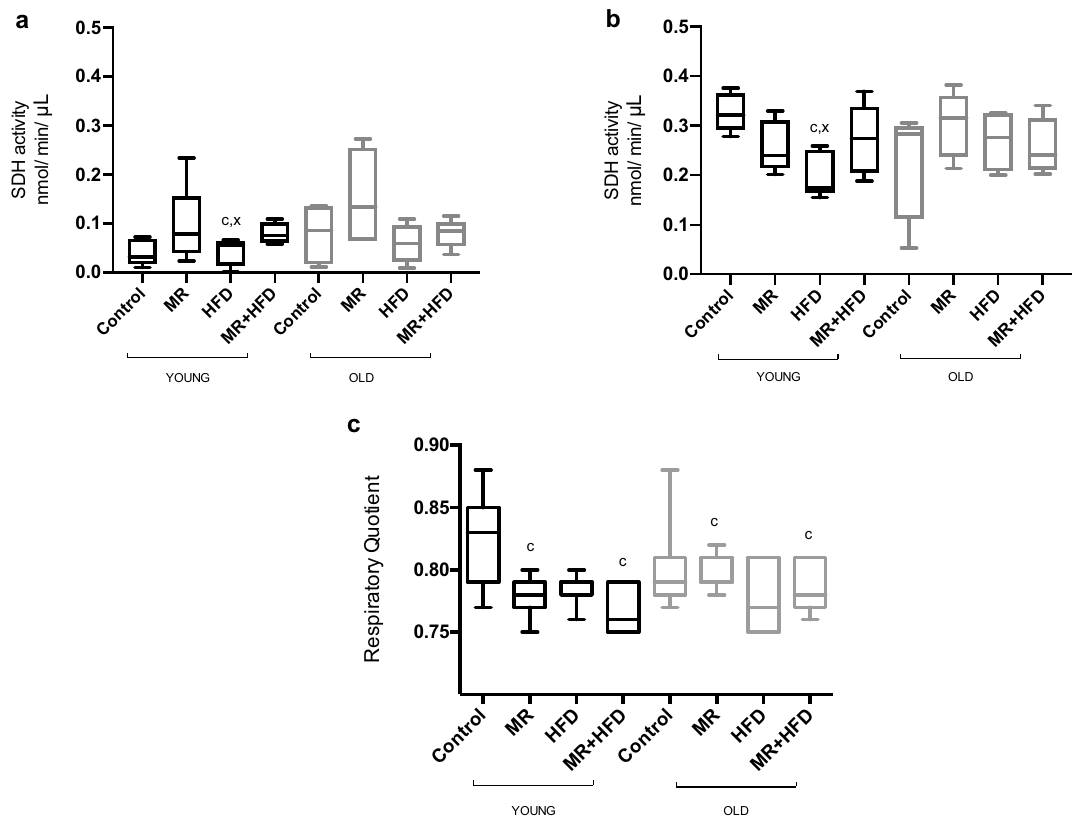
Figure 5. Succinate dehydrogenase (SDH) activity in ( a ) m. gastrocnemius and ( b ) m. soleus ; ( c ) respiratory quotient (RQ) in young (black boxes) and old (grey boxes) mice fed—control, methionine restricted (MR), high fat diet (HFD), MR + HFD. For SDH activity ( a , b ): c: significantly different from control and MR + HFD in young mice at p ≤ 0.020. For RQ ( c ): c: significantly different from control in ( b ) young and ( c ) both young and old mice at p ≤ 0.011. Data is presented as mean, min,